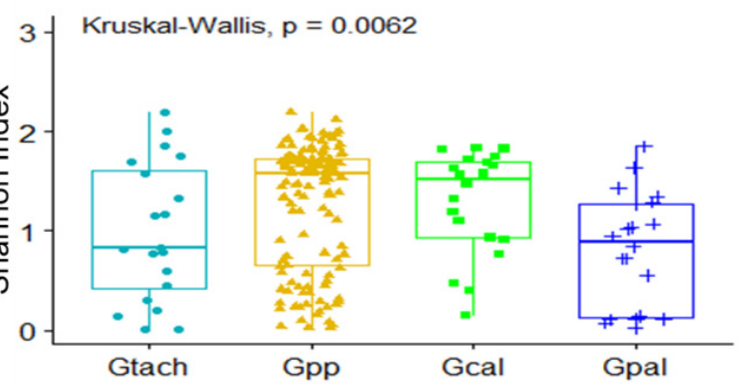
Figure 4. Microbiome diversity in different tsetse species (Gtach: Glossina tachinoides ; Gpp: G. palpalis palpalis ; Gcal: G. caliginea ; Gpal: G. pallicera pallicera ). 3.5.2. Diversity in Non-Teneral and Teneral Glossina palpalis